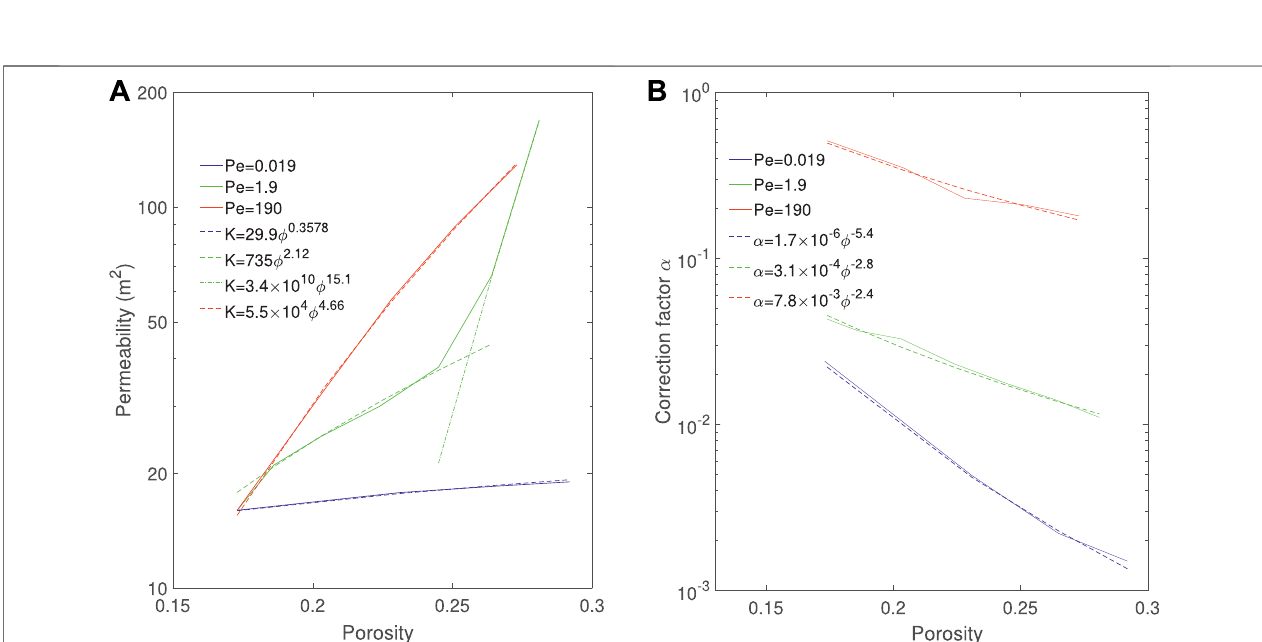
FIGURE 12 | Evolution of (A) permeability and (B) correction factor as a function of porosity and corresponding correlations during Ketton dissolution in three different regimes.